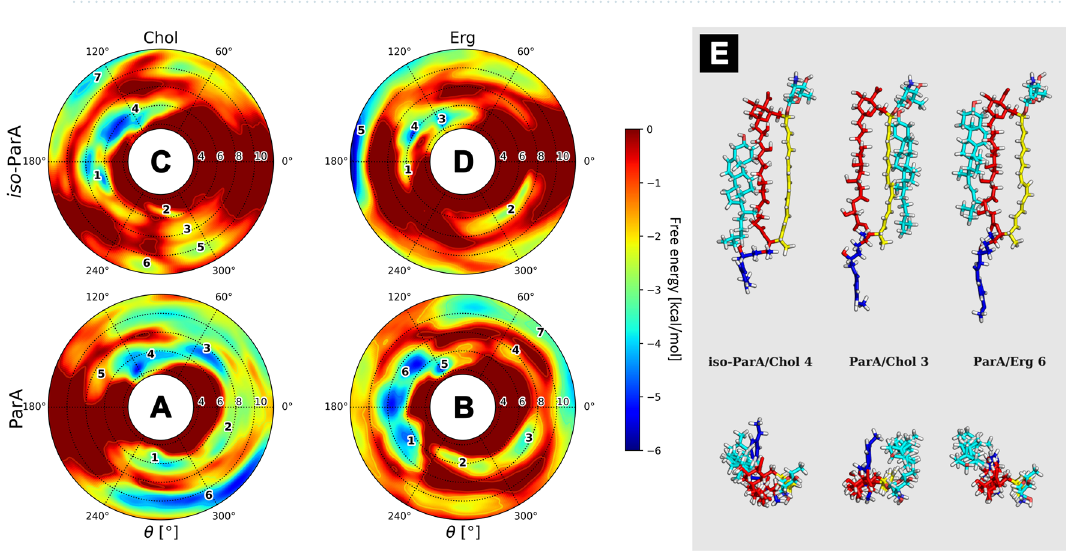
Figure 4. Free energy landscapes, calculated for partricin A (panels A & B ) and iso-partricin A (panels C & D ). Panel ( E ) contains representative structures of the (iso-)ParA/sterol complexes, extracted from selected energetic minima via cluster analysis. Number of a structure corresponds to the respective energetic minimum of a given system. Panel ( E ) colours: red—antibiotic’s polyol region; yellow—antibiotic’s heptaene chromophore; dark blue—alkyl-aromatic side chain; light blue—sterol